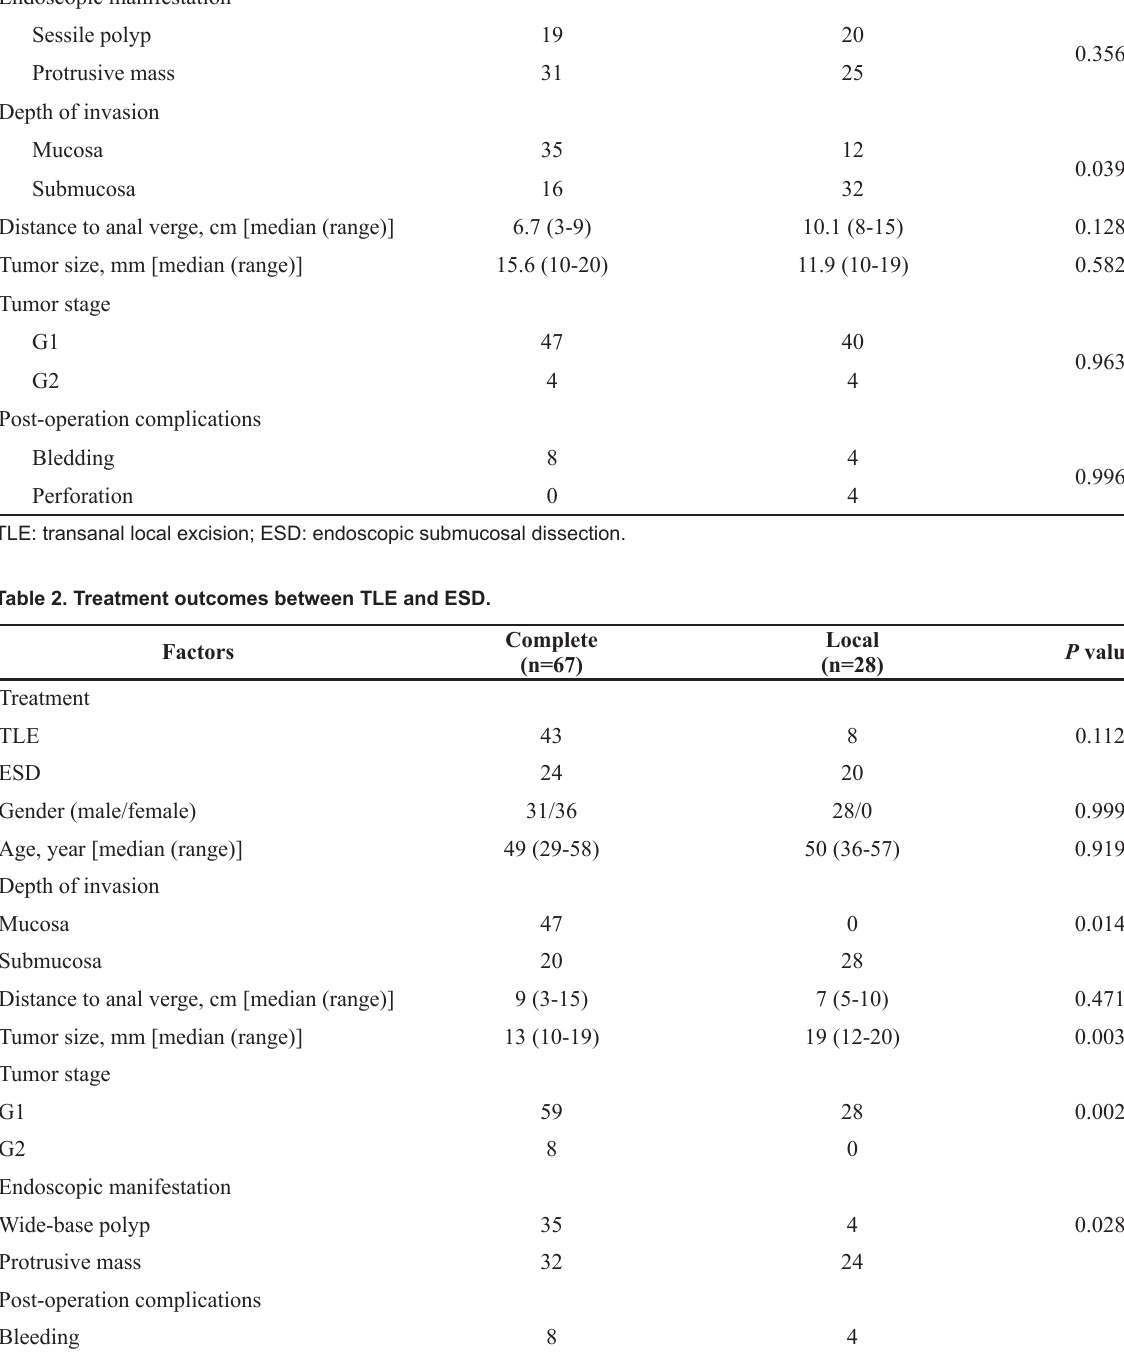
Table 2. Treatment outcomes between TLE and ESD. Age, year [median (range)]